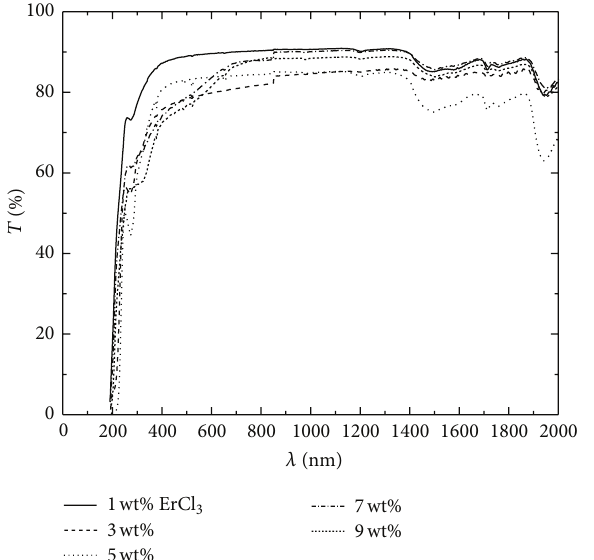
Figure 4: Transmission spectra for PVA contain different doping concentrations of ErCl 3 .